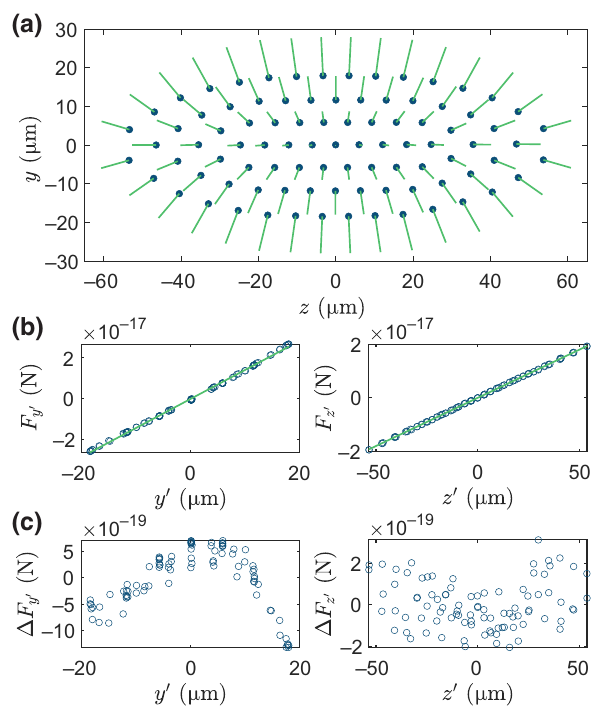
FIG. 3. Characterization of the trapping potential from an image of a 91-ion planar crystal. (a) The blue points indicate the positions of the individual ions, and green lines represent the forces exerted on the ions (arbitrary units). (b),(c) Force compo- nents F y (cid:8) and F z (cid:8) and their residuals (cid:11) F y (cid:8) and (cid:11) F z (cid:8) (with respect to the linear fit) along the two directions y (cid:8) and z (cid:8) of the rotated coordinate